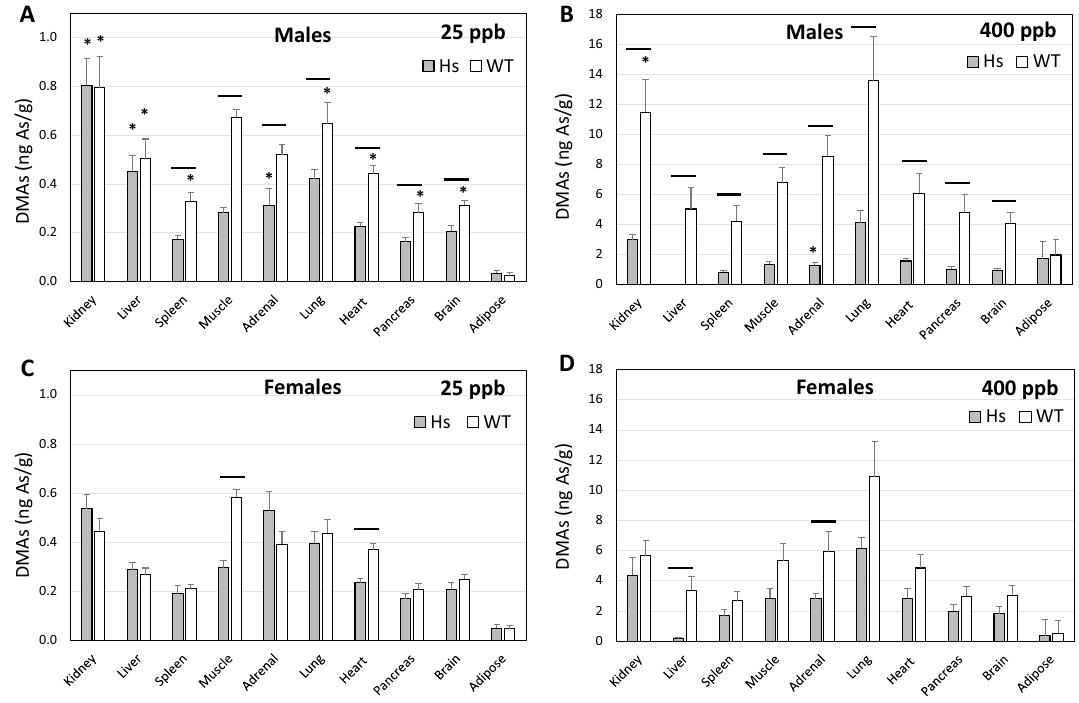
Figure 5. Concentrations of DMAs in tissues of humanized (Hs) and wild-type (WT) male and female mice after 4-week exposure to 25-ppb ( A , C ) or 400-ppb ( B , D ) of inorganic arsenic in drinking water. Each bar and whisker represent mean and SEM value, respectively. For 25-ppb exposure, N = 6 for Hs males and WT males, and N = 8 for Hs females and WT females. For 400-ppb exposure, N = 7 and 8 for Hs males and WT males, respectively, and N = 10 and 11 for Hs females and WT females, respectively. Horizontal line marks significant difference between genotypes for individual tissue; asterisk marks significant difference between males and females of the same genotype (p <